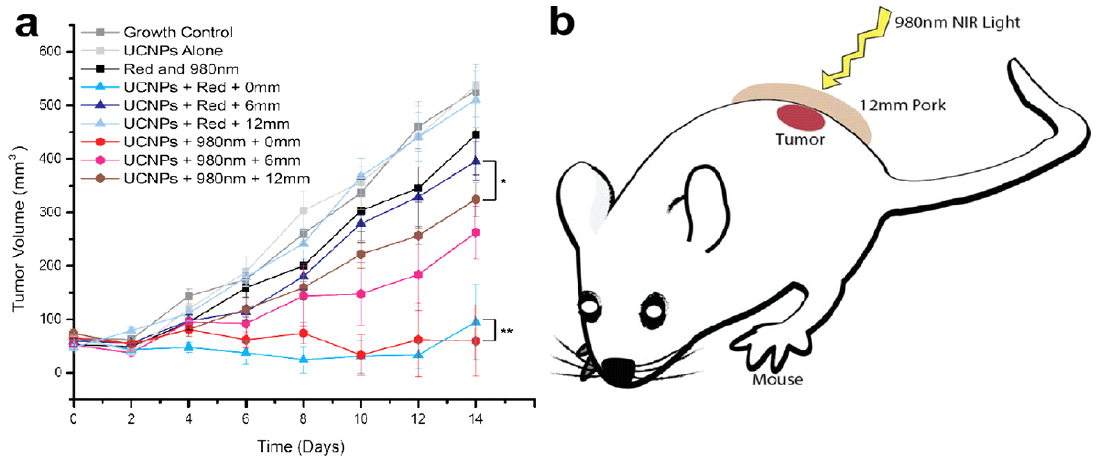
Figure 15. ( a ) In vivo volume of tumors exposed to various controls and ALA-UCNPs with red and near-infrared irradiation (0.5 W/cm 2 ) in simulated deep tumors, ( b ) scheme of the simulated deep tumor PDT process. Reprinted with permission from [51]. Copyright American Chemical Society,